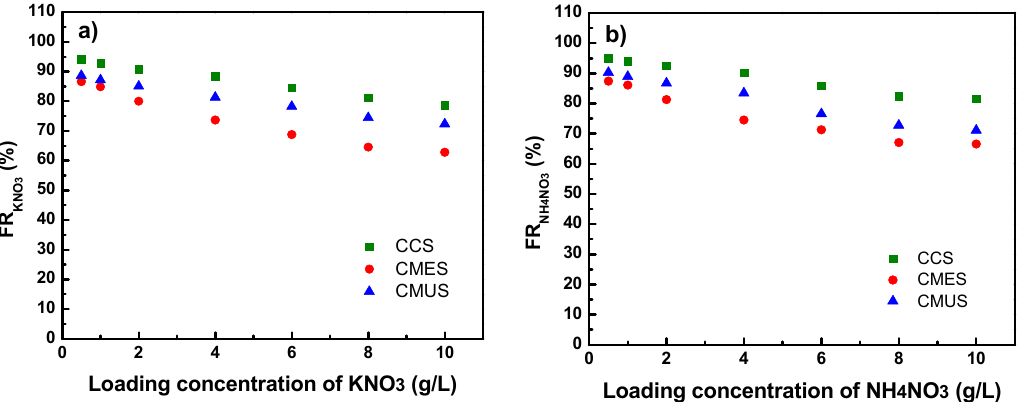
Figure 10. Fraction release of ( a ) KNO 3 and ( b ) NH 4 NO 3 at different loading concentrations.